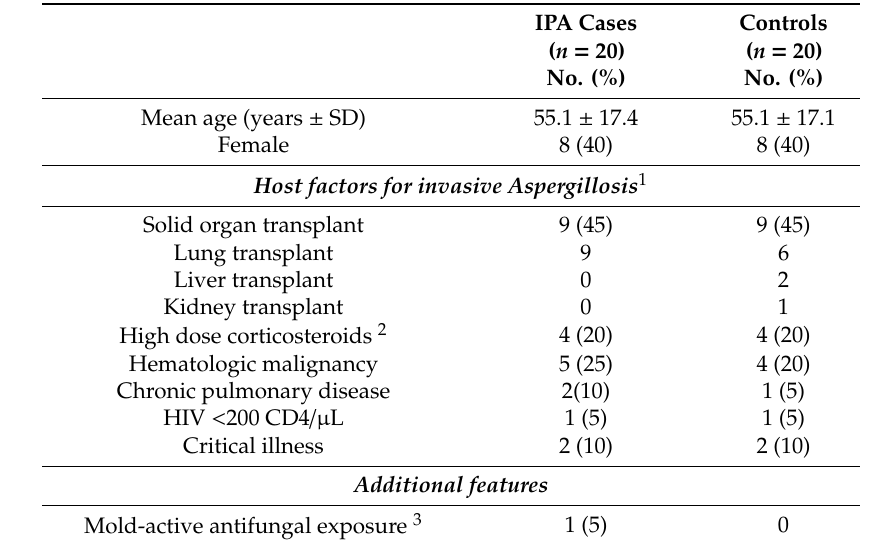
Table 1. Characteristics of patients with invasive pulmonary aspergillosis (IPA) and control patients who had bronchoalveolar lavage fluid samples tested with the Aspergillus galactomannan lateral flow